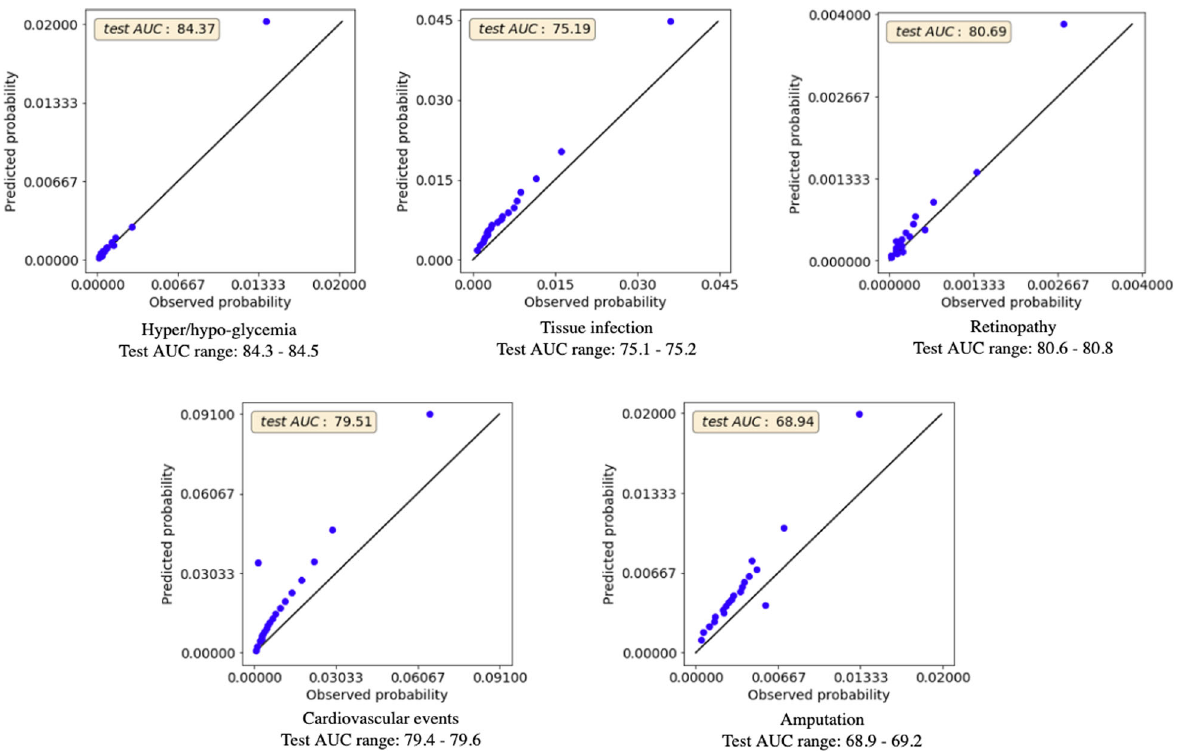
Fig. 2 Test set AUC and calibration curves for all six complications. The average test AUC is 77.74 (77.7 – 77.9). The model is retrained fi ve times with random restarts. The reported AUC results are averaged across the restarts. Corresponding ranges are also shown, low variance signi fi es that the results are stable. Calibration curves are computed using 20 bins of identical size, well-calibrated models have curves close to the identity line. Incidence rates vary signi fi cantly across complications (from 0.04 to 1.01%) so calibration curves have correspondingly different